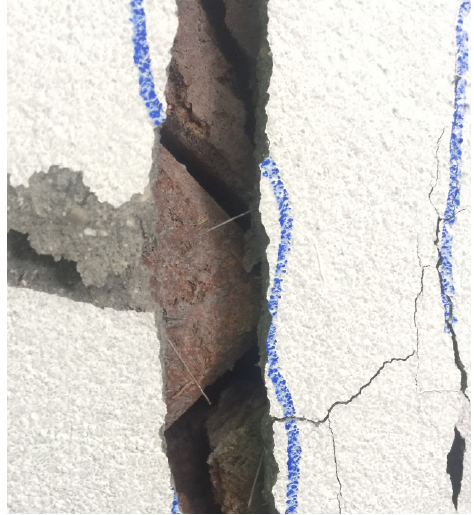
Figure 22. Fracture of wire mesh.